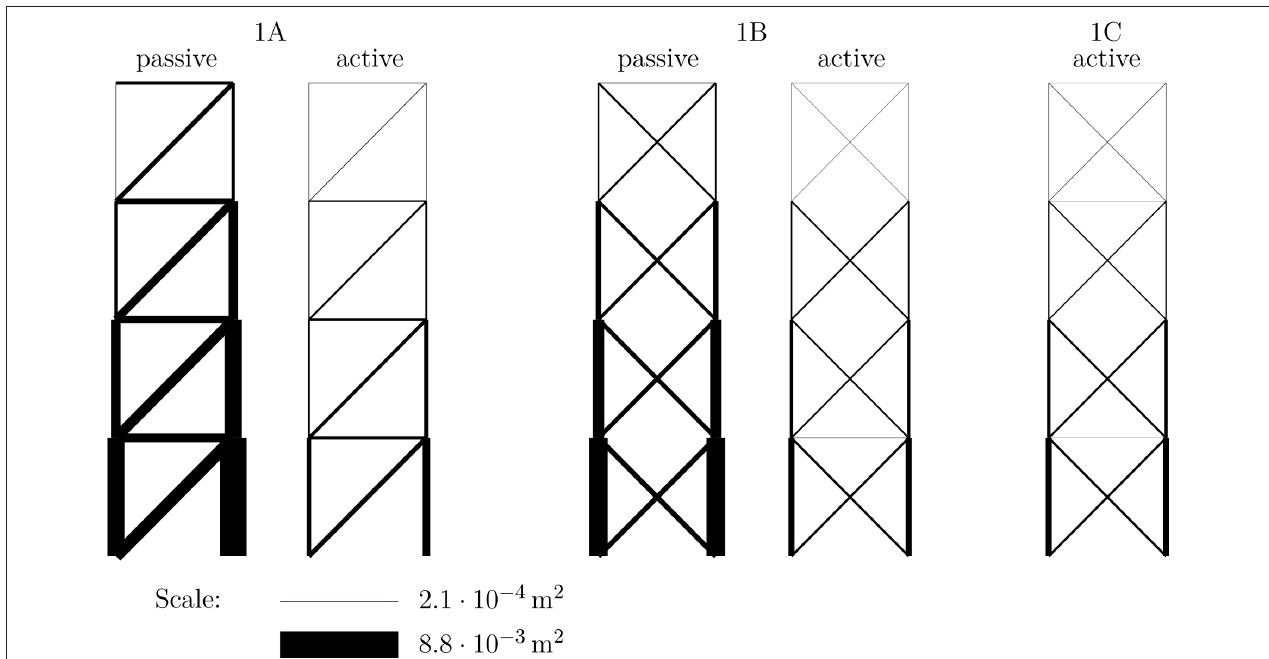
FIGURE 4 | Example 1, truss design: optimized cross-sectional areas.